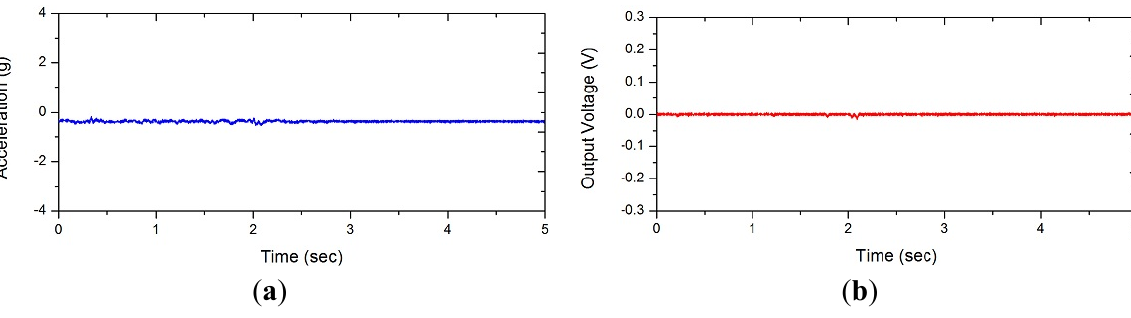
Figure 7. Signals from the control experiments. ( a ) Acceleration; ( b ) Harvester output signal.